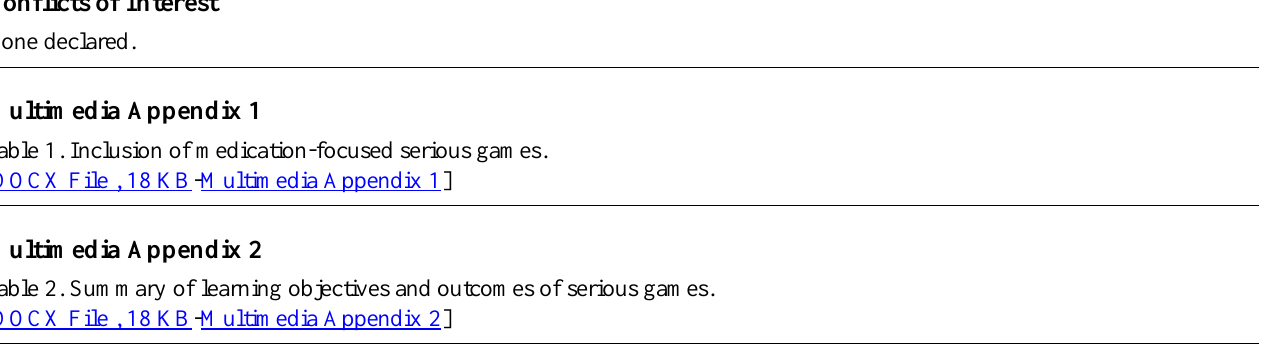
Table 2. Summary of learning objectives and outcomes of serious